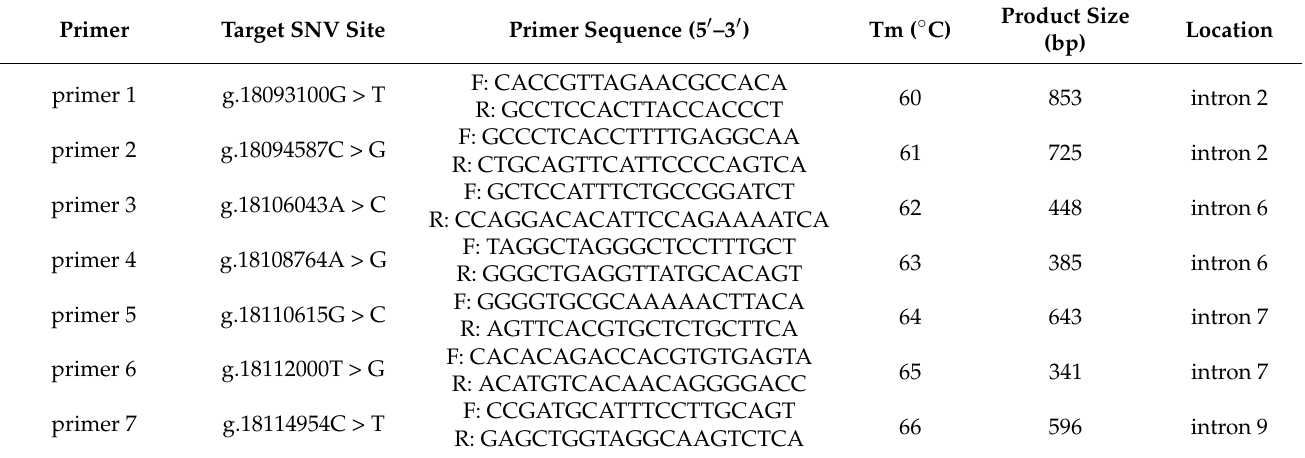
Table 1. Information of amplicon used for